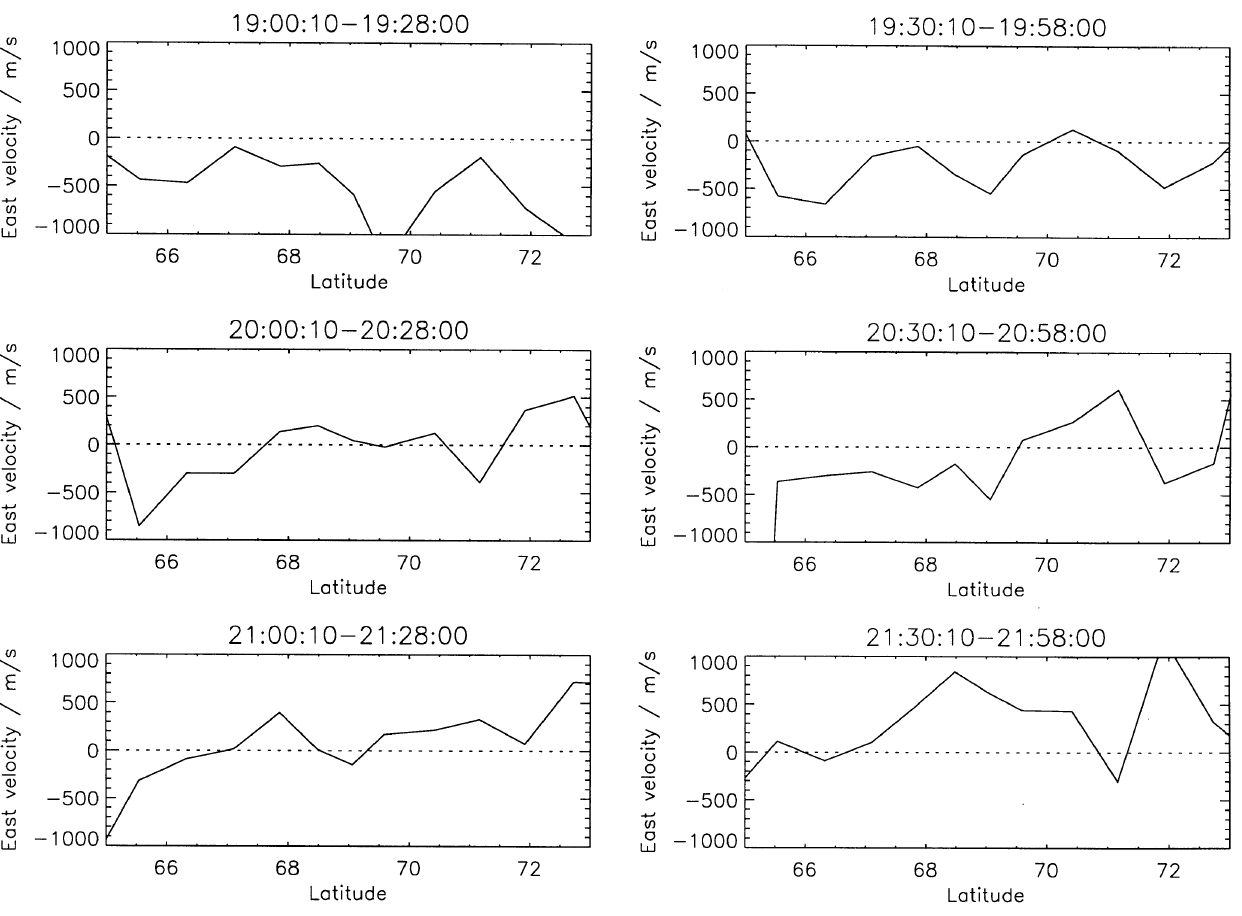
Fig. 10. East component of the plasma velocities measured by EISCAT at six south-north scans between 19:00 and 21:58